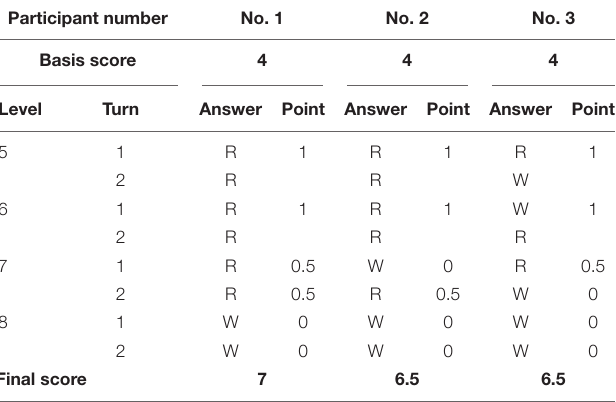
TABLE 3 | Example of scoring in the digit span